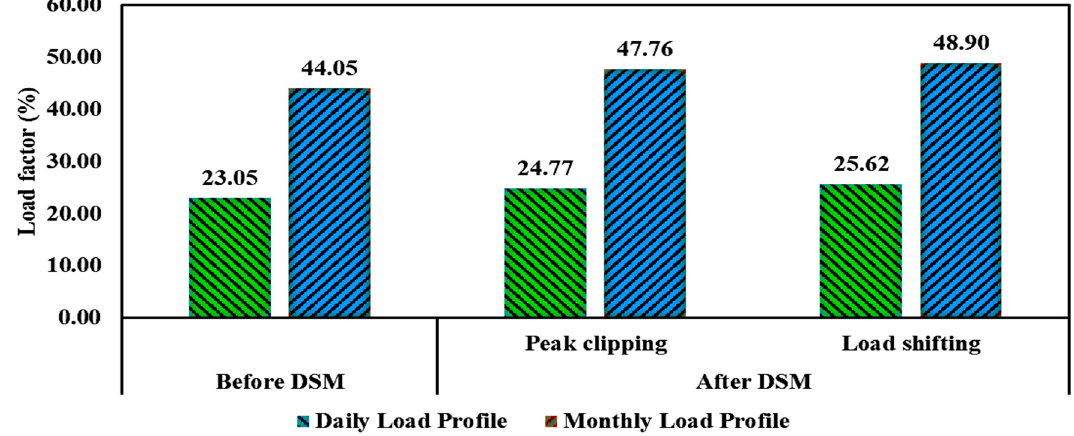
12 of 16 Figure 8. Seasonal profile before and after DSM using HOMER. Table 7. Comparison of average load, peak load, and electricity bill (EB) reduction–before and after DSM.